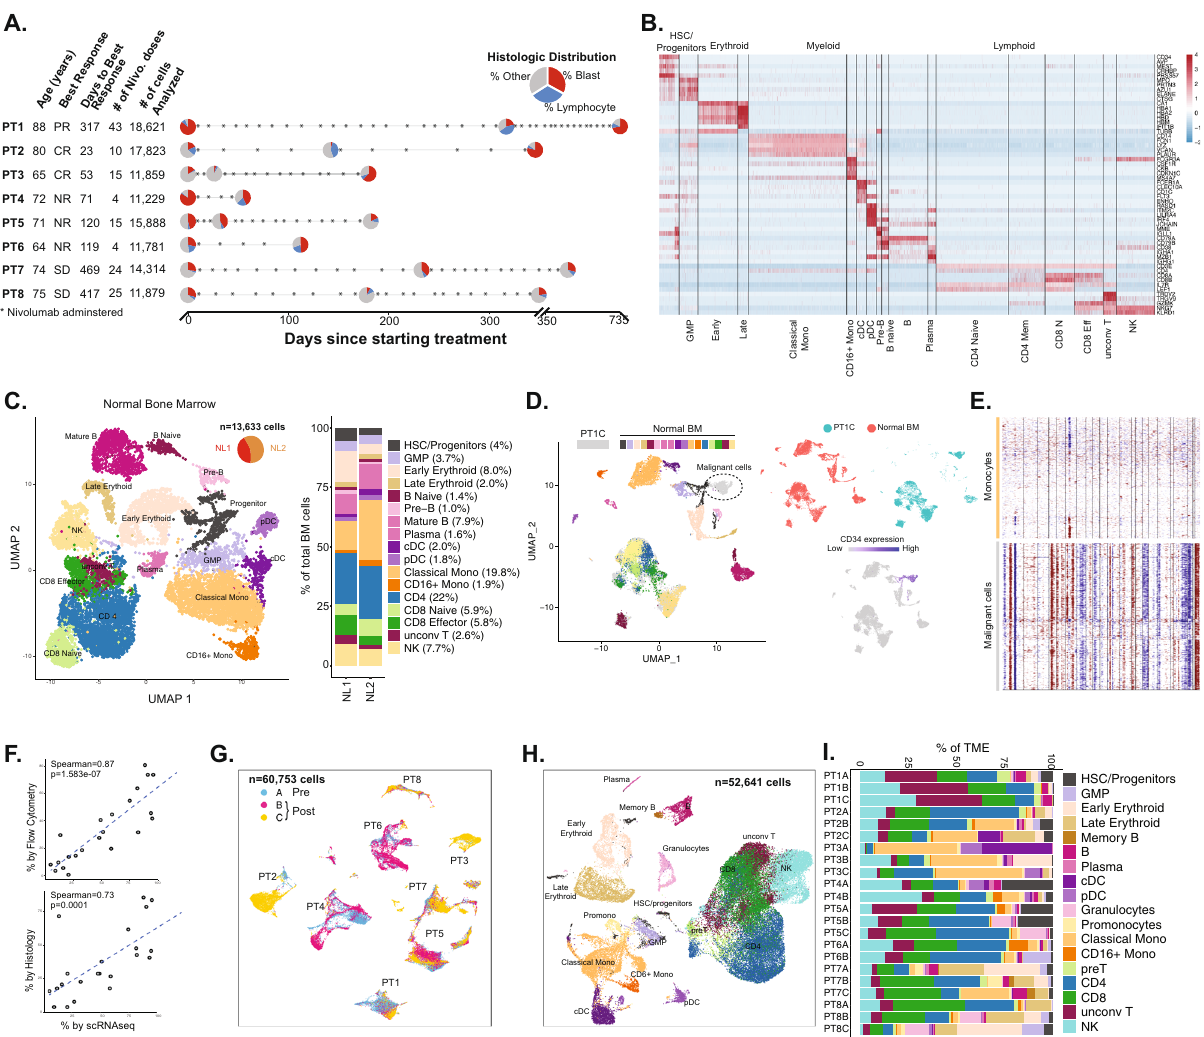
Fig. 1 Study design and single cell assessment of AML and healthy bone marrows. A Clinical design summarizing the age, response type per ELN, time to response, treatment frequency and the number of cells analyzed per patient. B Canonical gene expression markers to de fi ne the healthy bone marrow (BM) and tumor microenvironment (TME) cellular subsets. C UMAP-based analysis of healthy BM cellular components with frequency of each cell type. D Representative output of combining patient BM sample (represented by PT1, post-treatment timepoint C) with healthy BM donor cells demonstrating distinct clustering of tumor cells with concordant expression of CD34 con fi rmed by fl ow cytometry and immunohistochemistry, when available (Supplementary Fig. 3A – D). E Representative Inferring copy number variation of malignant cells compared to monocytes demonstrate concordant cytogenetic pro fi ling, further con fi rming AML cell identity. F Spearman correlation between the number of cells detected by scRNA versus fl ow cytometry and histopathology. G UMAP clustering of AML cells. H UMAP clustering of TME components. I Distribution of TME components in AML patients at different timepoints (A is pre-treatment, B and C are post-treatment samples). PR partial response, CR complete response, NR no response, SD stable disease, HSC hematopoietic stem cell, GMP granulocyte – monocytic progenitor, cDC conventional dendritic cell, pDC plasmacytoid dendritic cell, unconv T unconventional T, NK natural progression. Three NR and 1 SD patients had relative reduction in their TCR clonality following treatment, while 1 SD patient (PT7) had a persistent increase in TCR clonality (Fig. 2C). T cells are adaptable and the capacity for TCR repertoire treatment reactivity is variable 19 . To investigate how the frequencies of each clone and identi fi ed signi fi cantly changed ones following treatment (Fisher ’ s exact p < 0.05) (Fig. 2D). Novel clones (not detected at pre-treatment) constituted 43% of signi fi cantly expanded clonotypes (Fisher ’ s exact p < 0.05) (Fig. 2D, E). Association with clinical response revealed different patterns of clonotype change in abundance. Speci fi cally, the majority (77%) of signi fi cantly expanded clones were found in responders (77%) and patients with SD (18%), whereas the